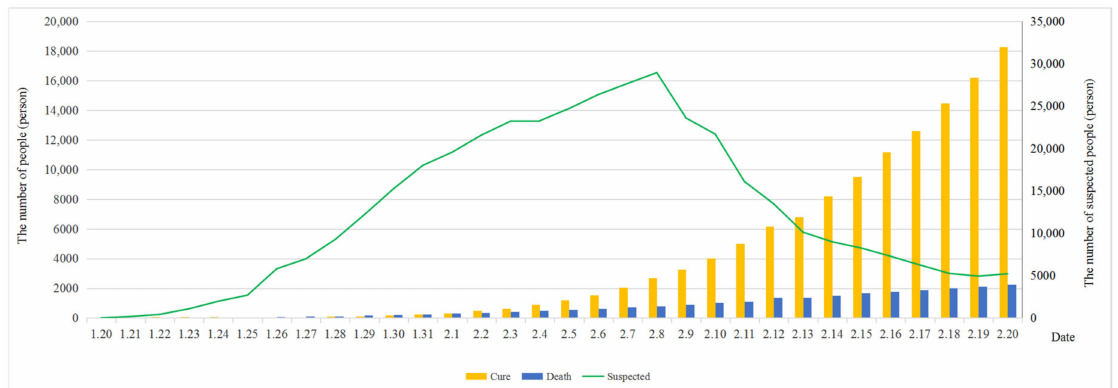
Figure 2. Cumulative numbers of suspected cases, deaths and cured patients in China from January 20 to 20